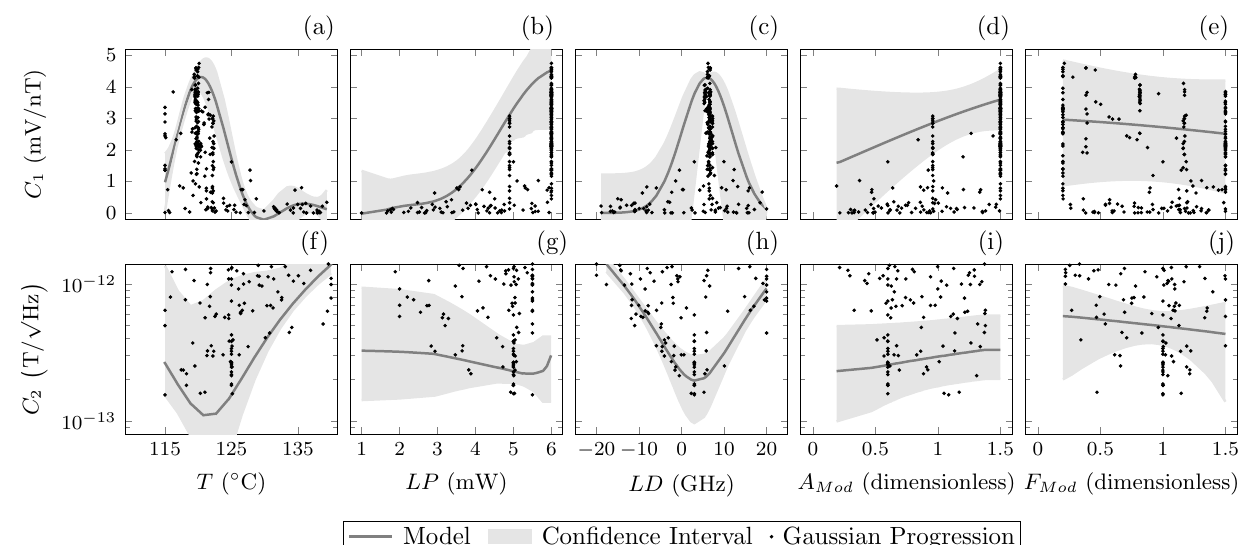
Figure 6. Data and models resulting from the Gaussian process regression model MLA, from a 5 parameter optimisation scheme ( M = 5). The 5 parameters optimised are cell temperature (T), laser power (LP), laser detuning (LD), modulation amplitude factor ( A Mod ) and modulation frequency factor ( F Mod ). Each part shows a parameter as a function of the cost. Row 1, ( a–e ), shows optimisation for cost function C 1 , the demodulated line shape gradient (mV/nT). Row 2 , ( f–j ) optimisation for cost function C 2 , calculated sensitivity (T/ √ Hz). Marks indicate measured values from optimisation, solid line indicates the Gaussian process predicted cost-landscape and shaded region indicates the model provided 95% confidence interval of the